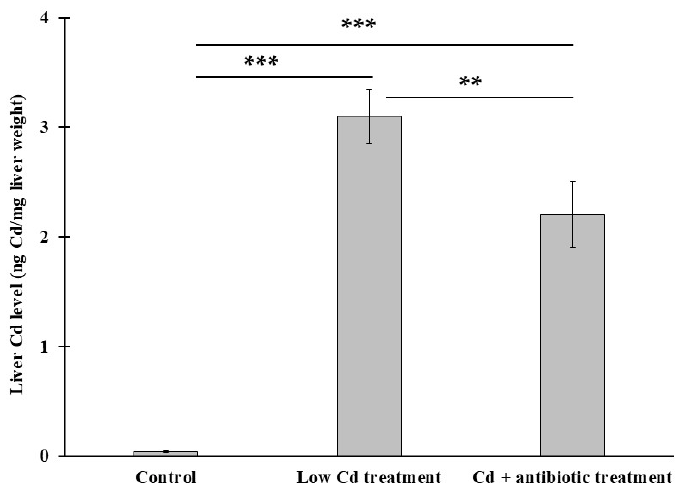
Figure 8. Cd concentration in mice livers. ** p < 0.01, *** p < 0.001.